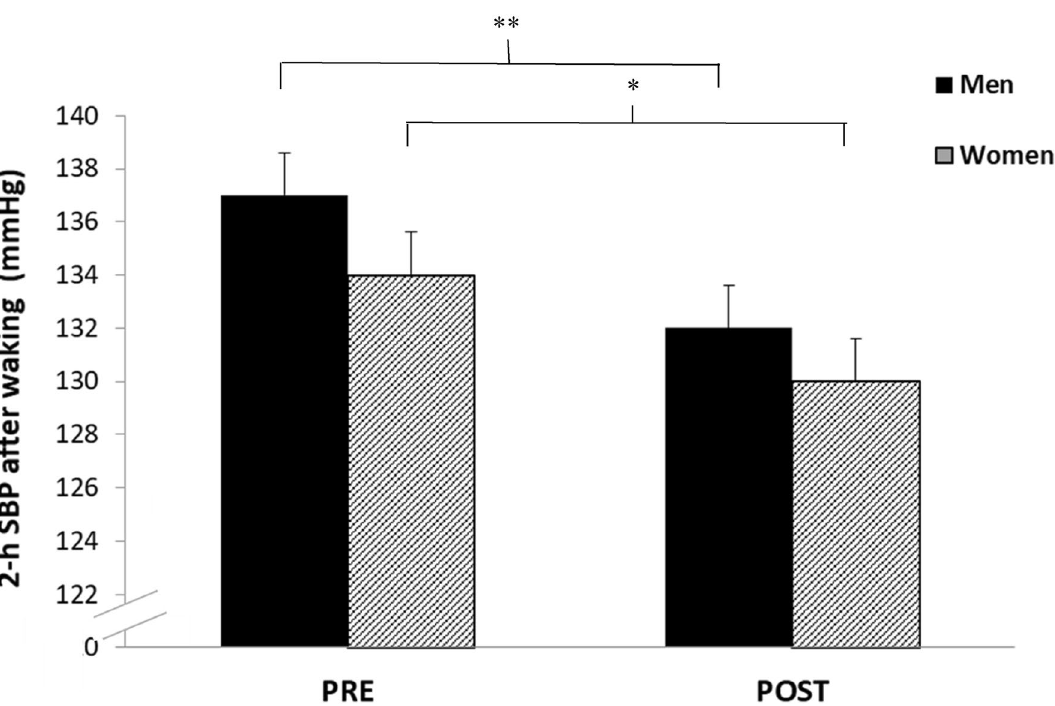
Figure 4. Effects of 10 weeks of isometric resistance training (IRT) on mean 2-h systolic blood pressure (SBP) after waking for men and women. * P value < 0.05, ** P value <